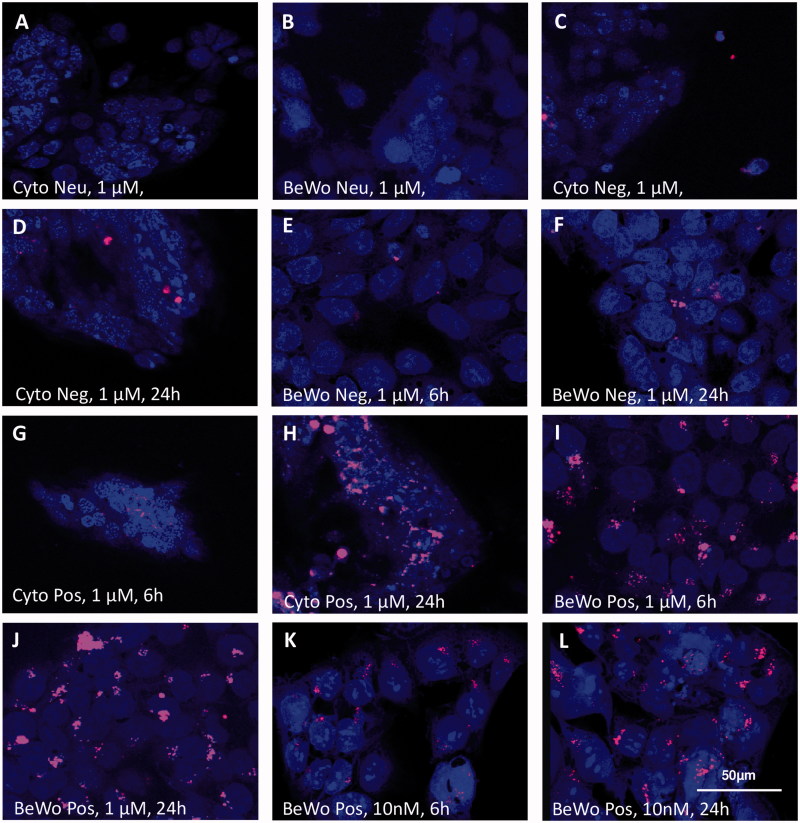
Localization of differently charged (neutral (Neu; A,B), negative (Neg; C–F), positive (Pos; G–L)), labeled dPG-NPs (pink) in exposed primary cytotrophoblasts (A–D,G,H), and BeWo cells (B,E,F,I–L). Exposure concentrations: 1 µM (A–J) and 10 nM (K,L)), exposure time: 6 h (C,E,G,I,K), and 24 h (A,B,D,F,H,J,L). Nuclear staining: DAPI (blue). Confocal images, 400x. Patchy perinuclear and nuclear localization was seen after 6 h of exposure to 1 µM neg. dPG-NPs (C,E) and pos. dPG-NPs (G,I), increasing after 24 h. Notably, in BeWo cells pos. dPG-NP deposits were also detected after exposing them to a 10 nM concentration for 6 h (K) and 24 h (L). No neutral dPG-NP deposits were detected in both cell types (A,B).